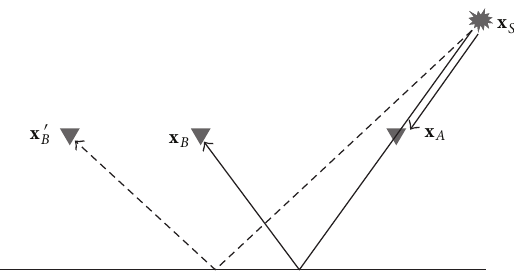
Figure 3: Source x S is a stationary source for the crosscorrelation